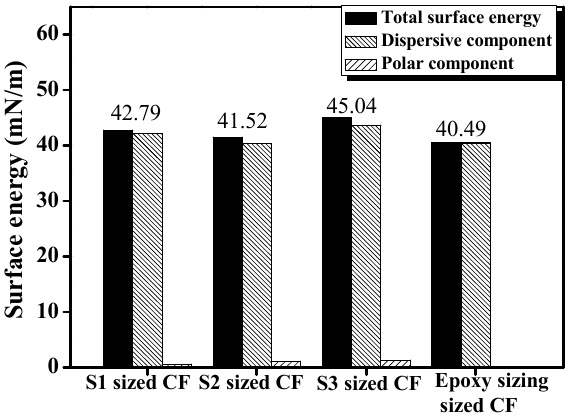
Figure 9. The surface energy of SC1, SC2, SC3 and epoxy sizing sized CFs.